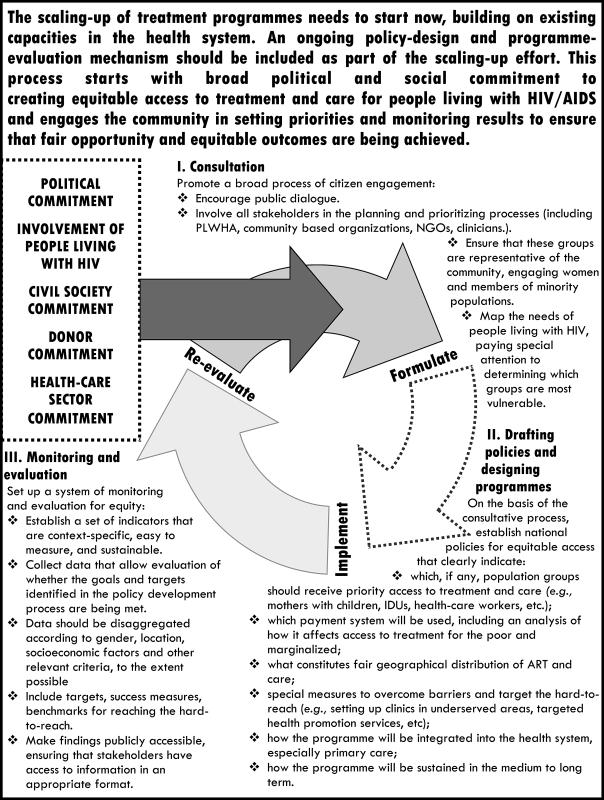
Steps to Equitable Access—The Policy Development Cycle at a GlanceIDU, intravenous drug user; NGO, non-governmental organization; PLWHA, people living with HIV/AIDS. (Source: [9])